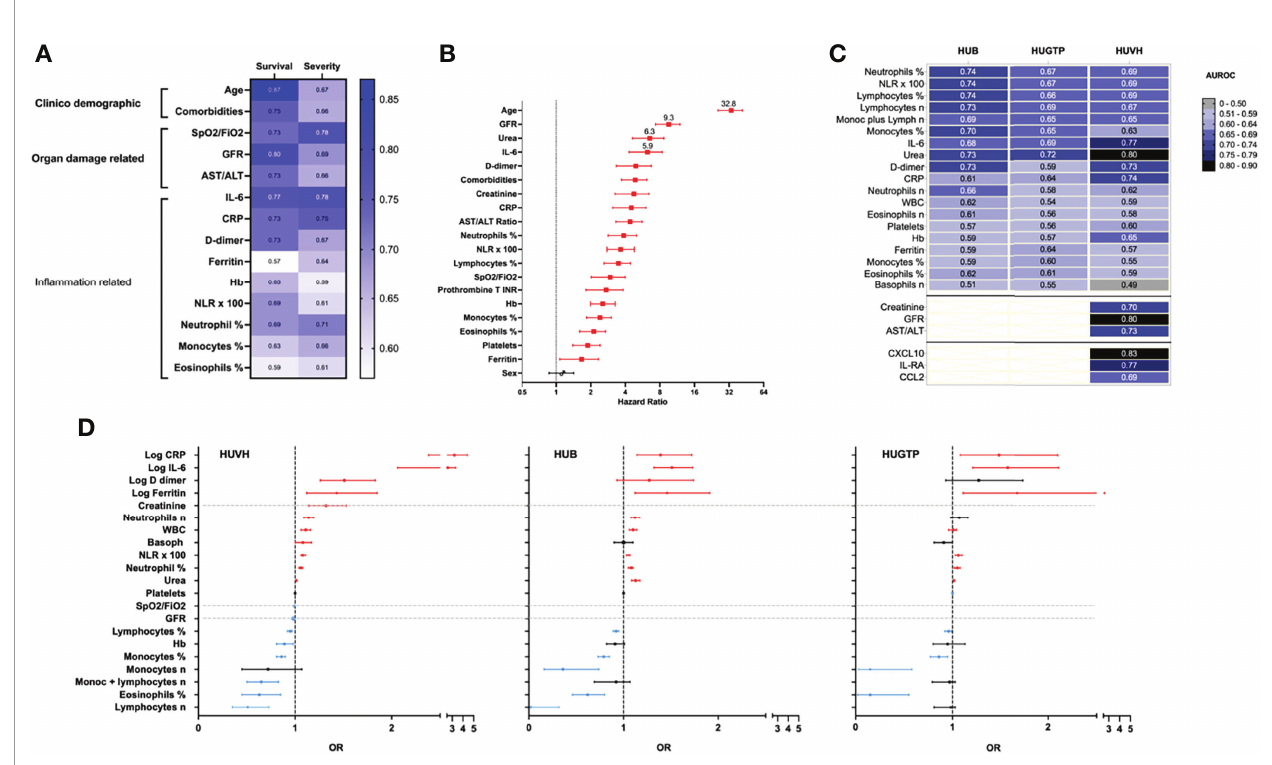
FIGURE 5 | Relative weight of different variables in prediction and performance. (A) Heatmap summarizing the values under the curve (AUC) generated by applying Receiver Operating Characteristic (ROC) curve routinely used to assed the performance of clinical laboratory tests, to each the main variables; the performance was assessed by survival/decease and for non-severity/severity outcomes in the HUVH cohort. (B) Hazard ratios corresponding to survival curves for Youden index cut- off. Red, signi fi cant values for the HUVH cohort. (C) Heatmap of the area under the curve (AUC) of ROC curves corresponding to the variables available for the three cohorts (HUB, HGTP and HUVH). The values have grouped by unbiased hierarchical clustering. IL-6, CRP, urea, lymphocytes, and neutrophils occupy central positions. At the bottom, the AUC for some variables available only from the HUVH cohort and the AUC values for the three cytokines that perform better in the group of 74 patients who were analyzed in the HUVH cohort. The numbers within the cells are the AUC values. (D) . Multivariable logistic regression analysis, age- adjusted, for the main variables of the three cohorts (HUB, HGTP and HUVH). The three forest plots show how, after correcting for age, the APRs rank above the glomerular fi ltration rate (GFR) in the HUVH cohort and have a similar ranking in the three cohorts. The horizontal whiskers represent the 95% con fi dence intervals; values in red indicate positive predictive and blue negative predictive value for the 28-day survival/deceased outcome. The dotted lines indicate variables only available for HUVH. The OR rankings -differently from the ROC AUCs- are useful only to compare the different hospital cohorts, but not to compare the weight of the variables within each cohort, as ORs are derived from variables that use different units and ranges of variation. APR, acute-phase reactants. APR, acute-phase reactants; SpO2/FiO2, oxygen saturation/fraction of inspired oxygen; NLR, neutrophil-to-lymphocyte ratio; CRP, C-reactive protein; AST, aspartate aminotransferase; ALT, alanine aminotransferase; GFR, glomerular fi ltration rate; IL, interleukin; LDH, lactate dehydrogenase; Hb, hemoglobin; ROC, receiver-operating characteristic curve; AUC, area under the curve; HUB, Hospital Universitari Bellvitge, HUGTP, Hospital Universitari Germans Trias Pujol Hospital; HUVH, Universitari Vall